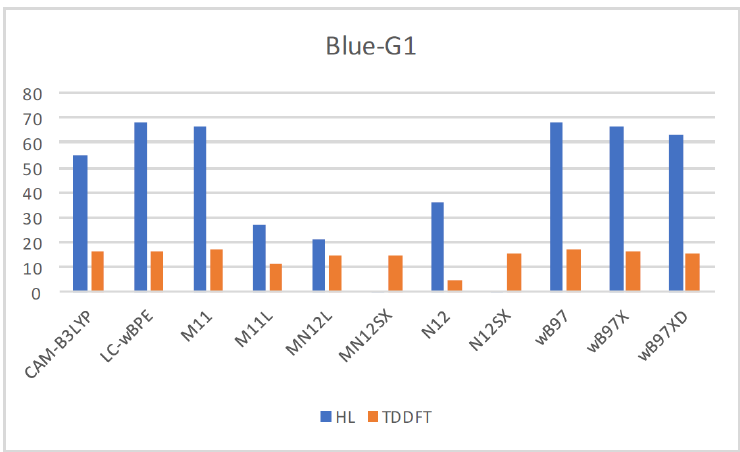
Figure 1. A graphical comparison of the results for the calculation of the λ max of the Blue-G1 pigment between the HOMO-LUMO gap prediction, the TDDFT values and the experimental